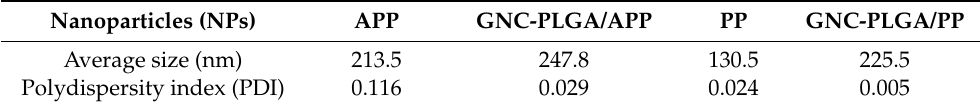
Table 1. Size distribution analysis of PLGA-PEG-OMe (PP) NPs, GNC-PLGA/PP NPs, d Asp 3 -PEG- PLGA (APP) NPs, and GNC-PLGA/APP NPs was evaluated by dynamic light scattering (DLS) analysis. Nanoparticles